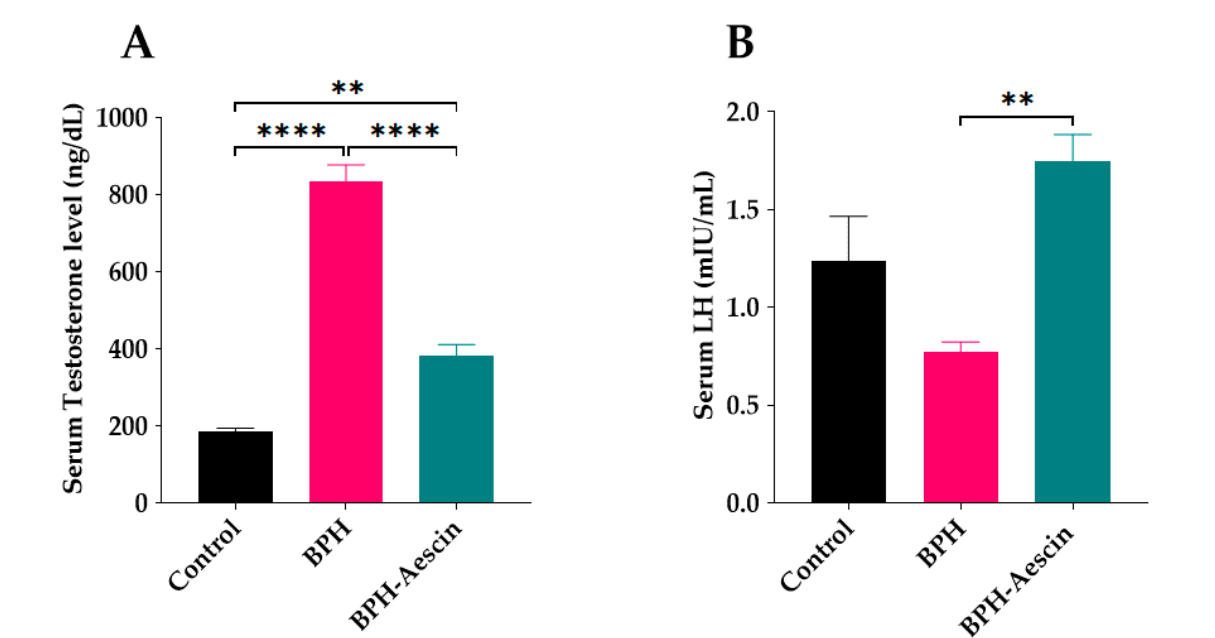
Figure 4. Aescin antagonizes testosterone-induced serum hormonal abnormalities. Serum samples were collected from control, BPH, and BPH–aescin groups, and were used for determination of: ( A ) serum testosterone and ( B ) luteinizing hormone (LH). The concentrations of testosterone or LH were determined by electrochemiluminescence immunoassay “ECLIA” kits as described in Section 4 Materials and Methods. Rats were subjected to a 4-week treatment protocol of sesame oil (control), testosterone (3 mg/kg, s.c.) dissolved in sesame oil (BPH), or testosterone (3 mg/kg, s.c.) dissolved in sesame oil + aescin (10 mg/kg, p.o.) (BPH–aescin). Data (mean ± SEM, n = 5) were analyzed by one-way ANOVA followed by Tukey’s multiple comparisons test. ** and **** denote significant differences between the selected study groups at p values < 0.01 and 0.0001, respectively.